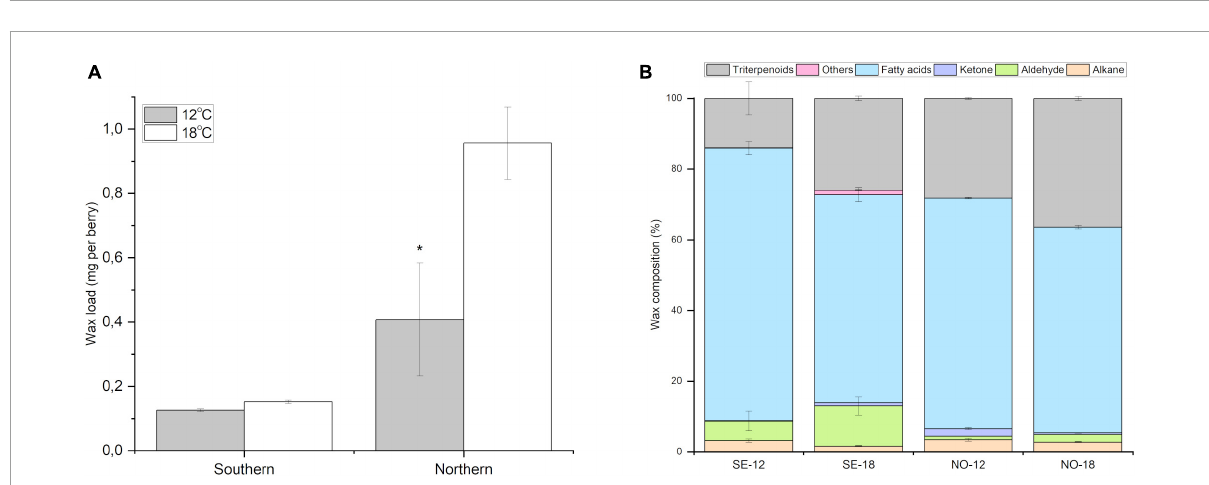
FIGURE4 Effect of temperature on berry cuticular wax. (A) Amount of cuticular wax (mg per berry) in bilberry fruits after phytotron experiments at 12 and 18 ◦ C in southern and northern bilberry clones. The data is shown as mean ± SD of three replicates ( n = 3). * Indicates the significant difference between the two temperature treatments ( P < 0.05) by student t -test. (B) Cuticular wax profile in bilberries from phytotron experiments from southern and northern clones at 12 and 18 ◦ C. Error bars indicate Standard Error ( n =